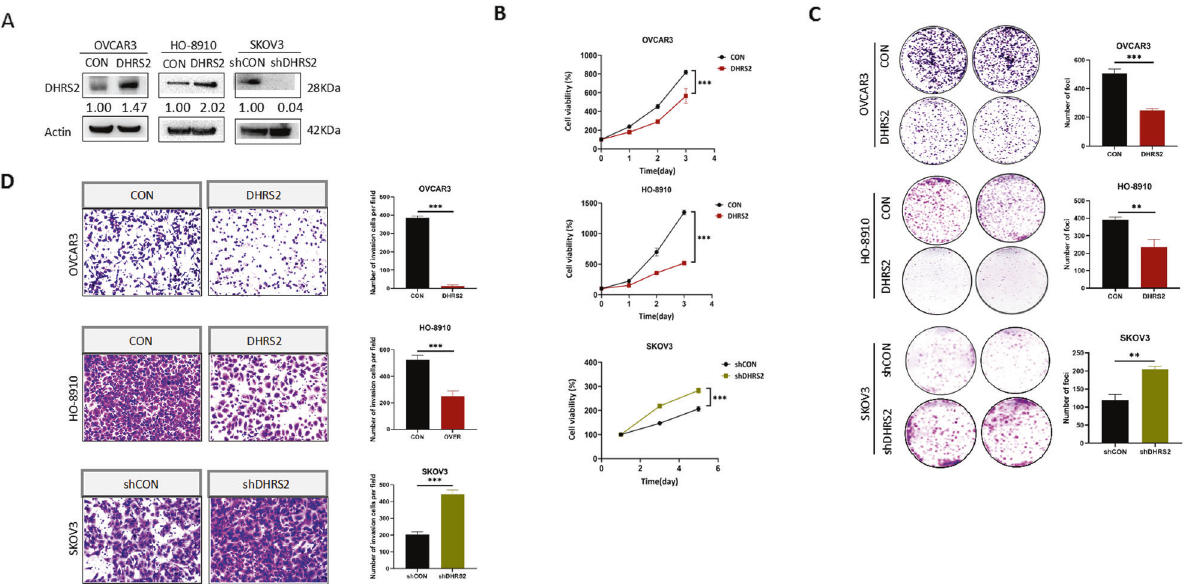
Fig. 1 DHRS2 Inhibits the growth and invasion in ovarian cancer cells. A DHRS2 protein expression levels of in OVCAR3-CON, OVCAR3- DHRS2, HO-8910-CON, HO-8910-DHRS2, SKOV3-shCON, and SKOV3-shDHRS2 cells. B Cell viability of the designated groups was detected by MTS assay. C Foci formation ability of the designated groups was determined by colony formation assay. D Cells were seeded in the upper chamber with Matrigel coating for 72 h, and cell invasion ability of the designated group was determined. Data are shown as mean values ± S.D. of independent, triplicate experiments. The asterisks (*,**,***) indicate signi fi cant differences ( p < 0.05, p < 0.01, p < 0.001,